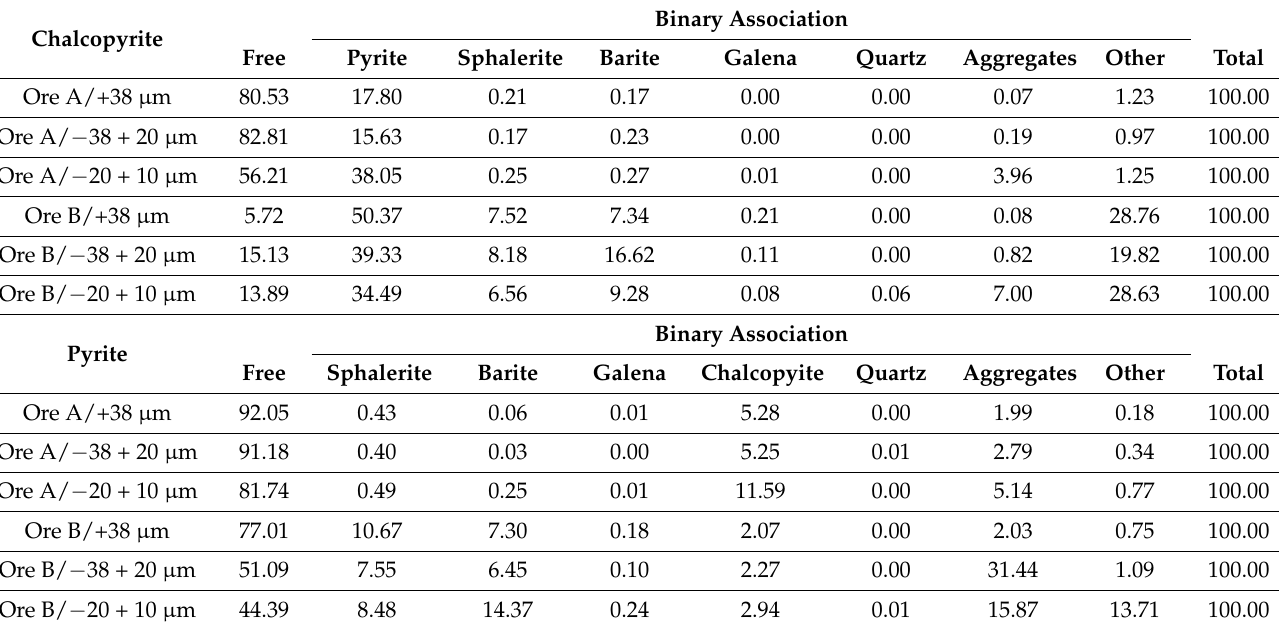
Table 5. Size-by-size liberation of chalcopyrite and pyrite minerals in Ore A and Ore